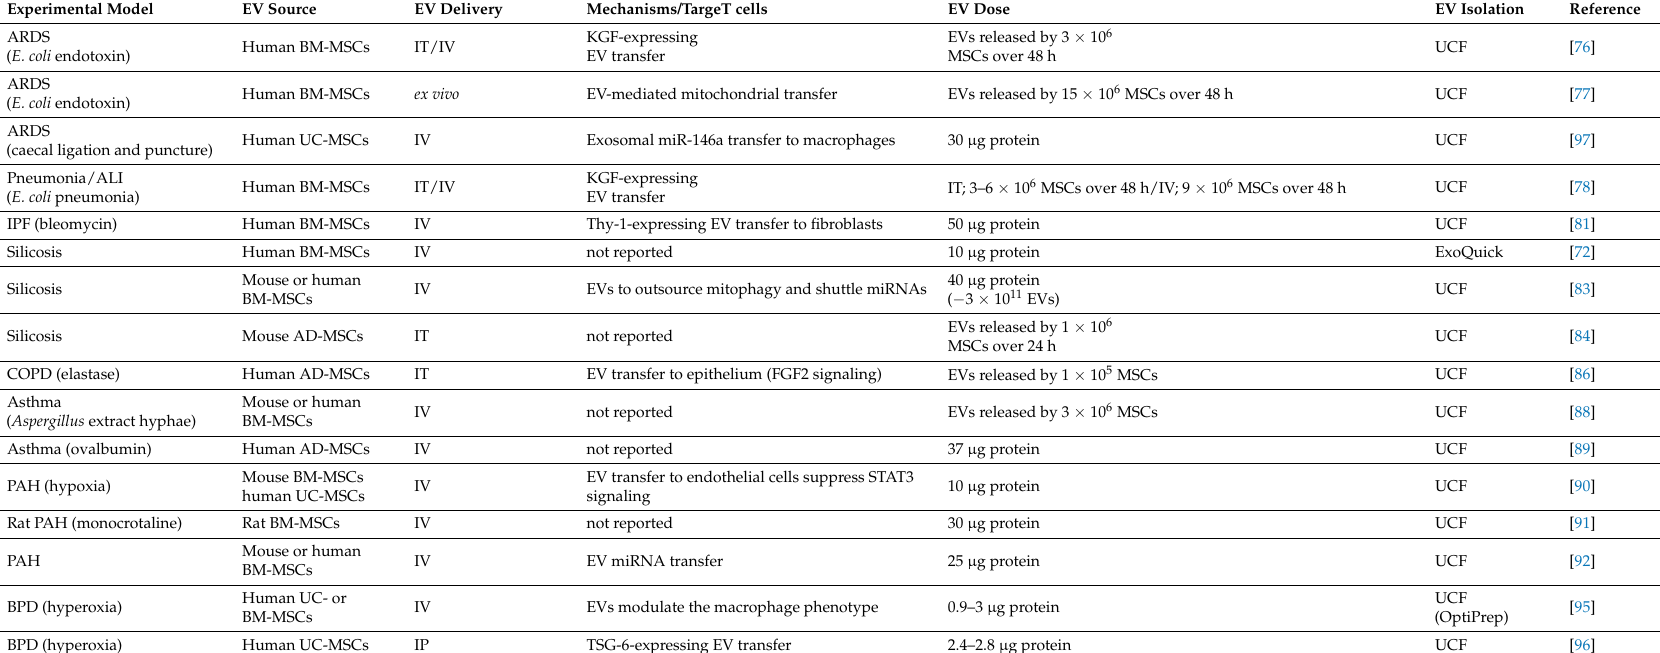
Table 1. Application of MSC-derived EVs in preclinical models of inflammatory lung